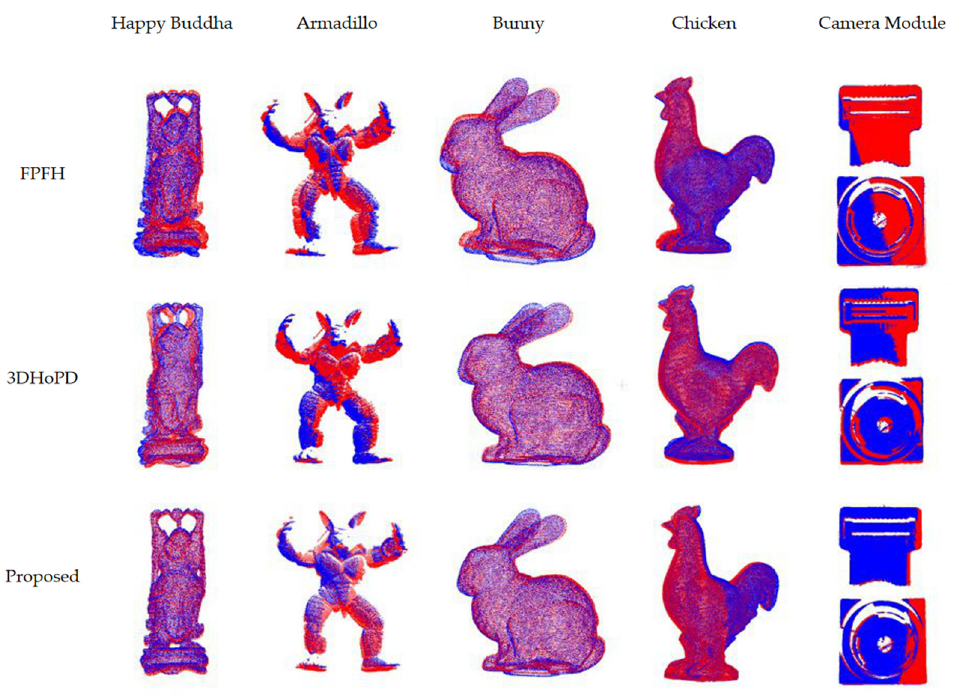
Figure 7. Registration results of the different algorithms. Table 4. Registration errors of five models.